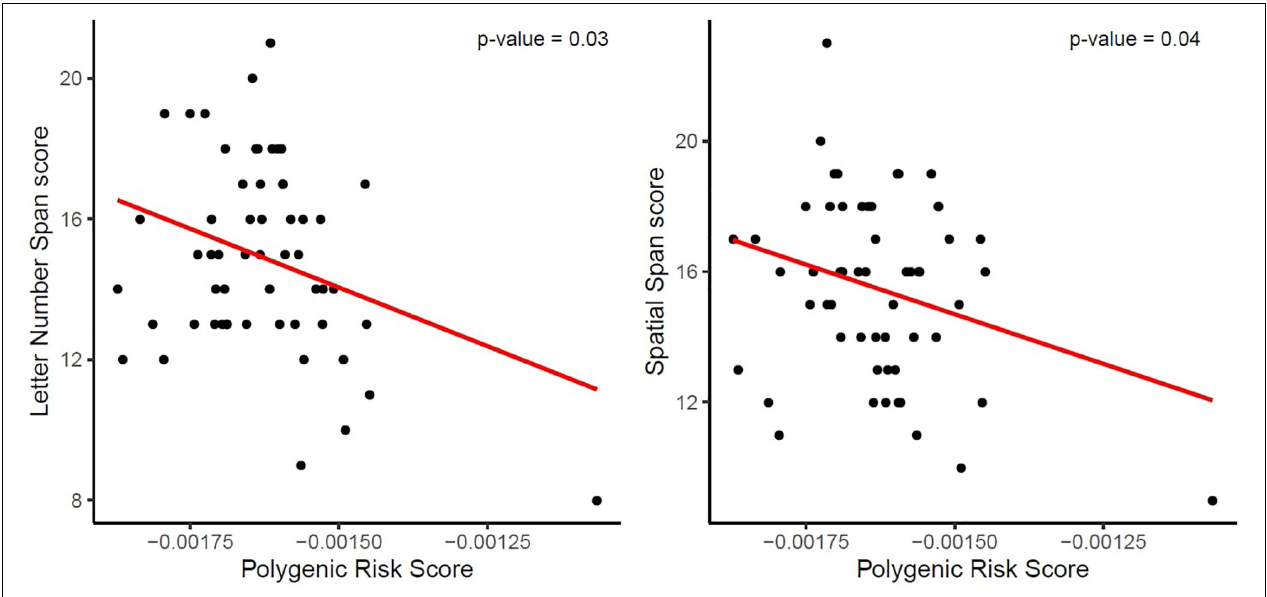
FIGURE 1 | Association between the Polygenic Risk Score (PRS) for AD and performance in working memory tests (Letter Number Span and Spatial Span). The red line demonstrates that a higher genetic risk for AD, reflected in a higher PRS, is associated with decreased working memory capacity, reflected in lower scores, in both